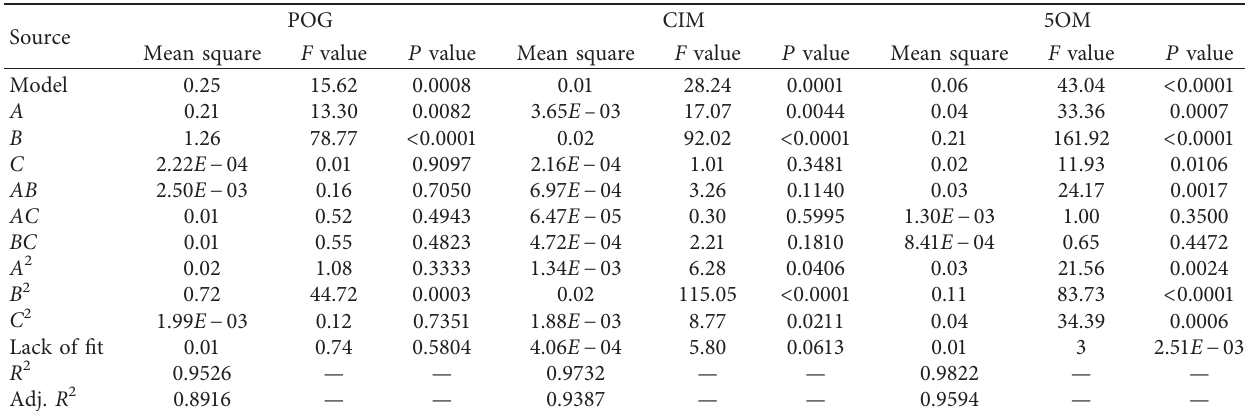
Table 3: ANOVA for response surface quadratic model analysis of variance